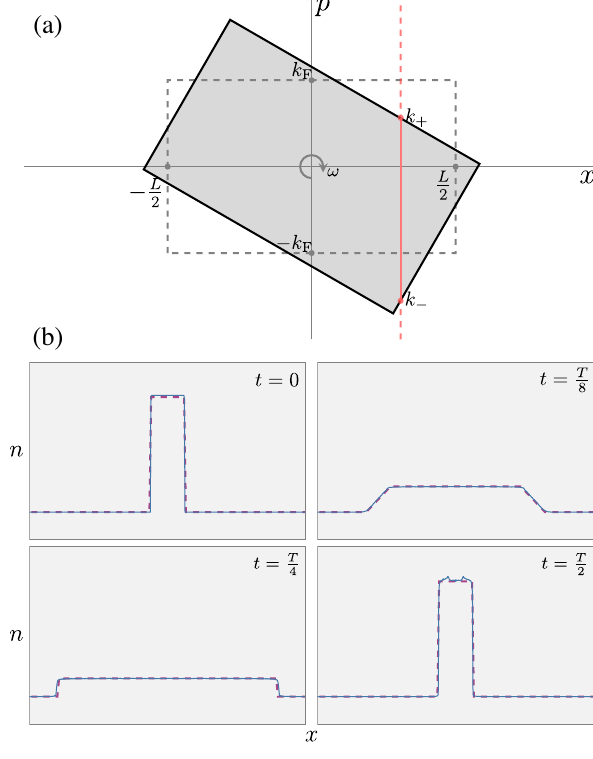
FIG. 2. Example I. (a) Schematic plot of the initial Wigner function, which is uniformly distributed inside the dashed rectangle, and the Wigner function at a finite time, which is uniformly distributed inside the solid rectangle. These two rectangles are related by a rotation with angle ω t . The red line and k are used in Appendix B for calculating momentum (cid:3) distribution at a given location x . (b) Density profiles n ð x; t Þ at t ¼ 0 ; T= 8 ; T= 4 ; T= 2 obtained by numerically solving the gen- eralized Gross-Pitaevskii equations (blue solid lines) and the exact solution constructed from the ideal-gas dynamics (red dashed